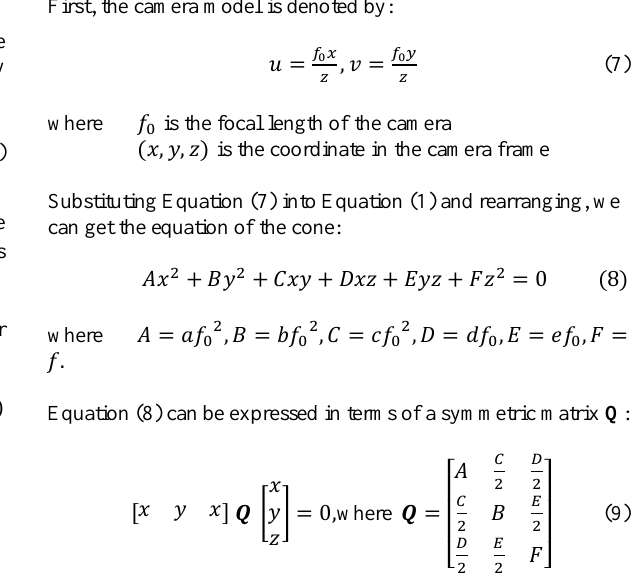
Figure 3. Elliptical projection of space circle on the image